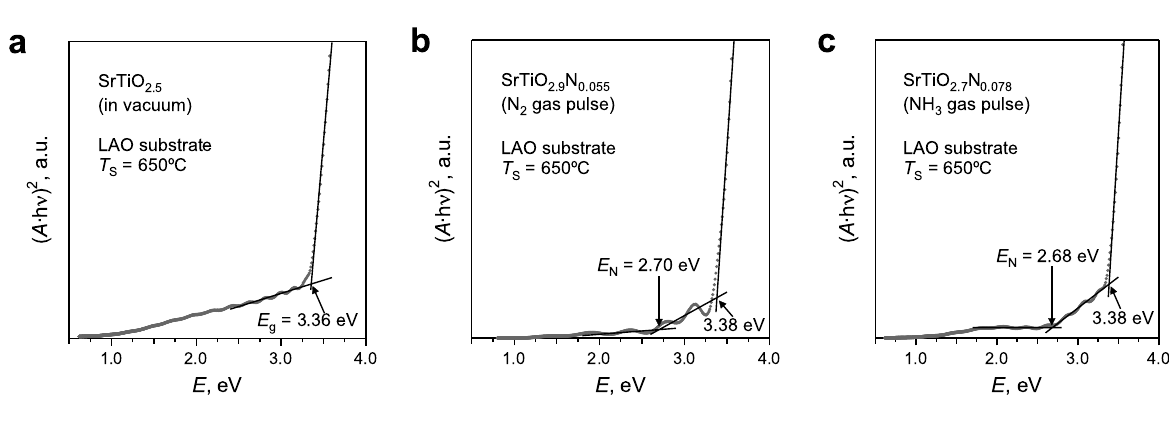
:N films deposited 3